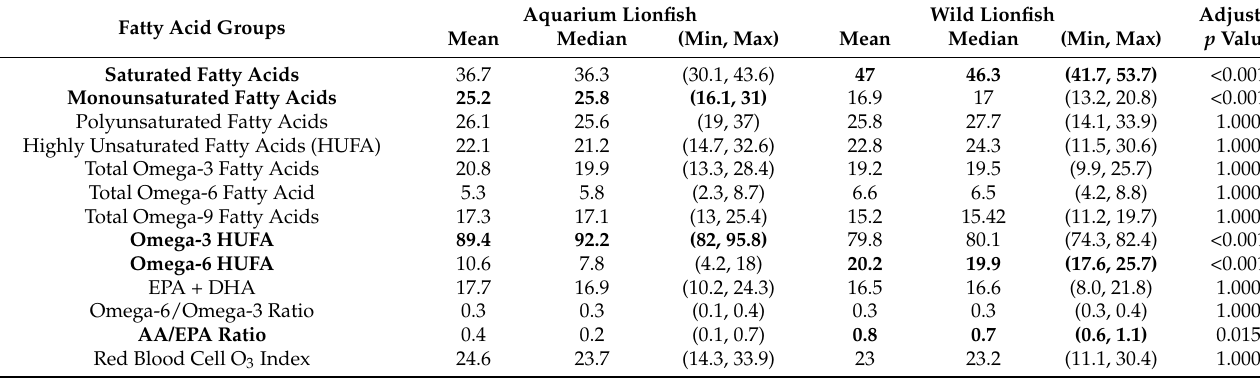
Table 3. Whole blood fatty acid groups of wild, invasive lionfish harvested off the coast of North Carolina and lionfish at the North Carolina Aquariums. Values are provided as a percent of total fatty acids present, except for omega-3 and omega-6 highly unsaturated fatty acids (HUFA), which are provided as a percent of HUFA present. To account for multiple comparisons, p values were adjusted using the Bonferroni correction. Fatty acid groups that significantly differ between wild and aquarium lionfish are in bold, with the higher mean, median, and (min, max) in bold . EPA: